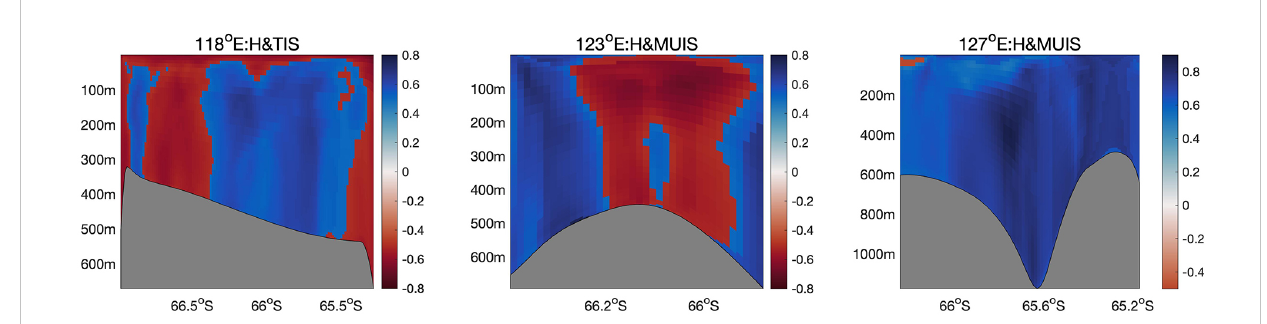
FIGURE 6 Vertical pro fi les of C eddy or C tide along various transects marked in Figure 5. Greyed regions are the sea fl oor. From left to right, the color scale indicates the dominant contributor (red = eddies, blue = tides) to the basal melt rate of TIS or MUIS along 118° E, 123° E and 127° E transects. Figure used cmocean (Thyng et al., 2016).